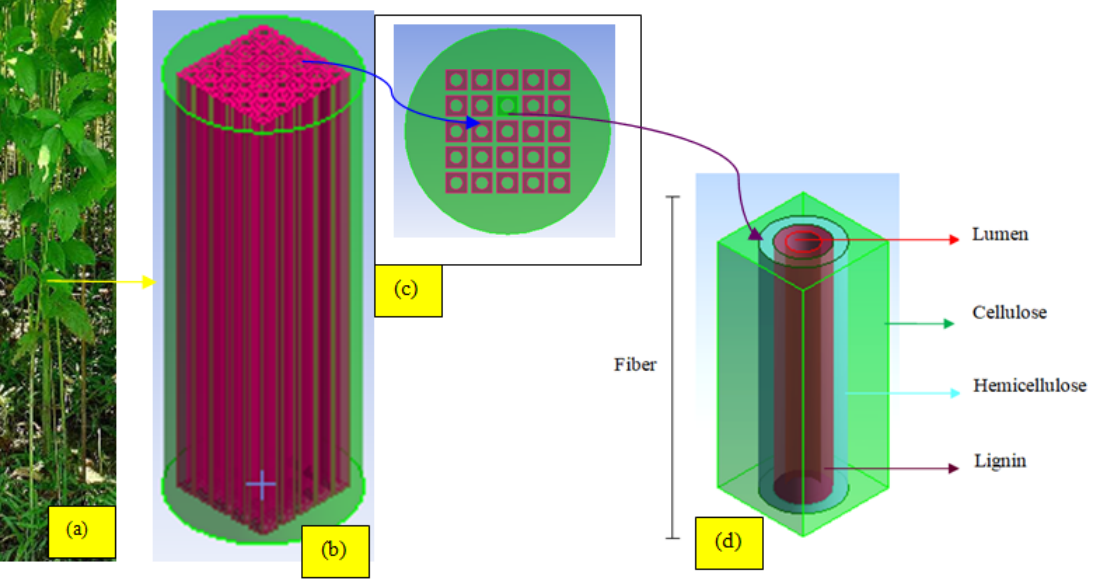
Figure 4. Representation of Natural fiber structure: jute plant ( a ) fiber bundle of the plant ( b ), cross-sectional view of the fiber bundle ( c ) and representation of single fiber with constituents ( d